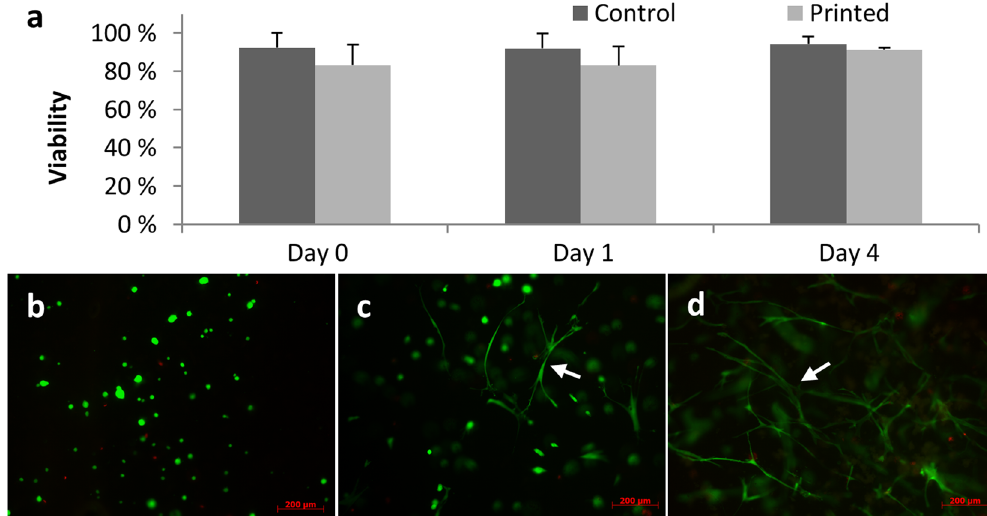
Figure 3. Cell viability after the printing process. Cell viability at day 0, 1 and 4 after preparation comparing control and printed samples ( a ). Cell images on the same day ( b ), after 1 day of cultivation ( c ) and after four days of cultivation ( d ) under fluorescence microscope (Stained with FDA/PI, 10x) showing a round morphology directly after printing and a highly stretched morphology (white arrows) and intercellular contacts for SMCs four days after the printing